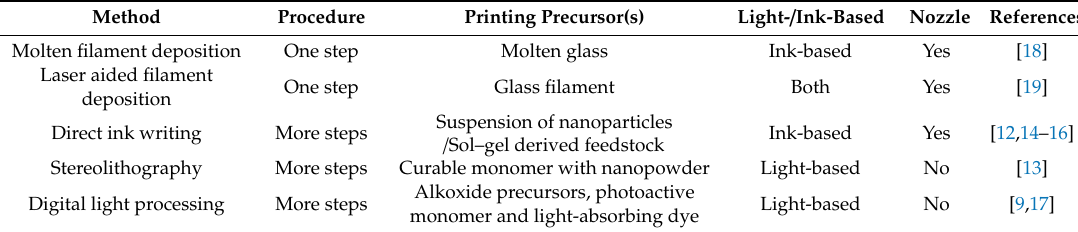
Table 1. Comparison of reported printing